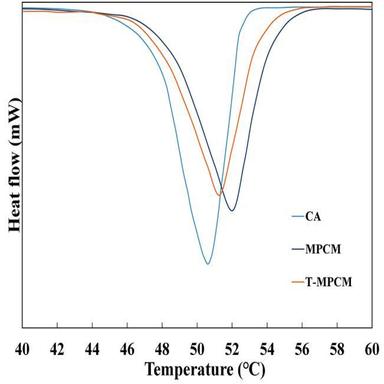
DSC curves of CA, MPCM, and T-MPCM.